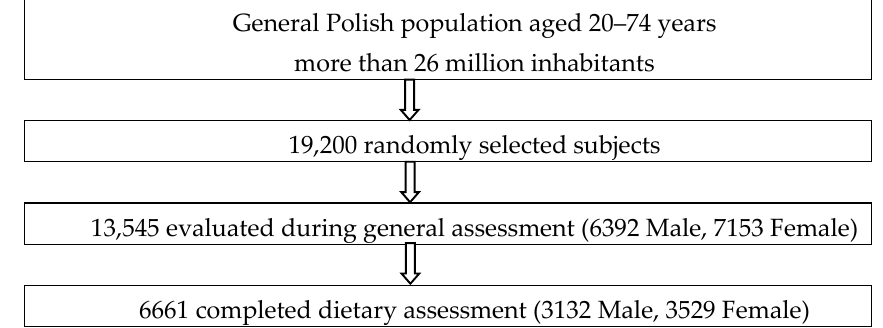
Figure 1. Flow-chart of study